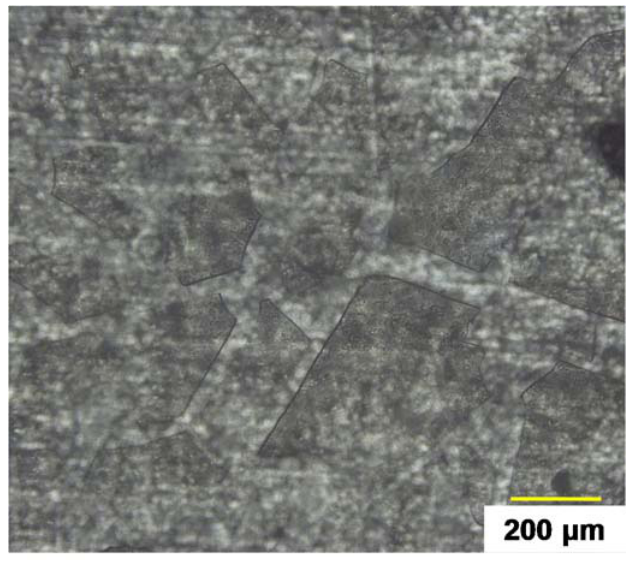
Figure 13. Surface observation for bilayer system at withdrawal speed of 600 mm min − 1 .